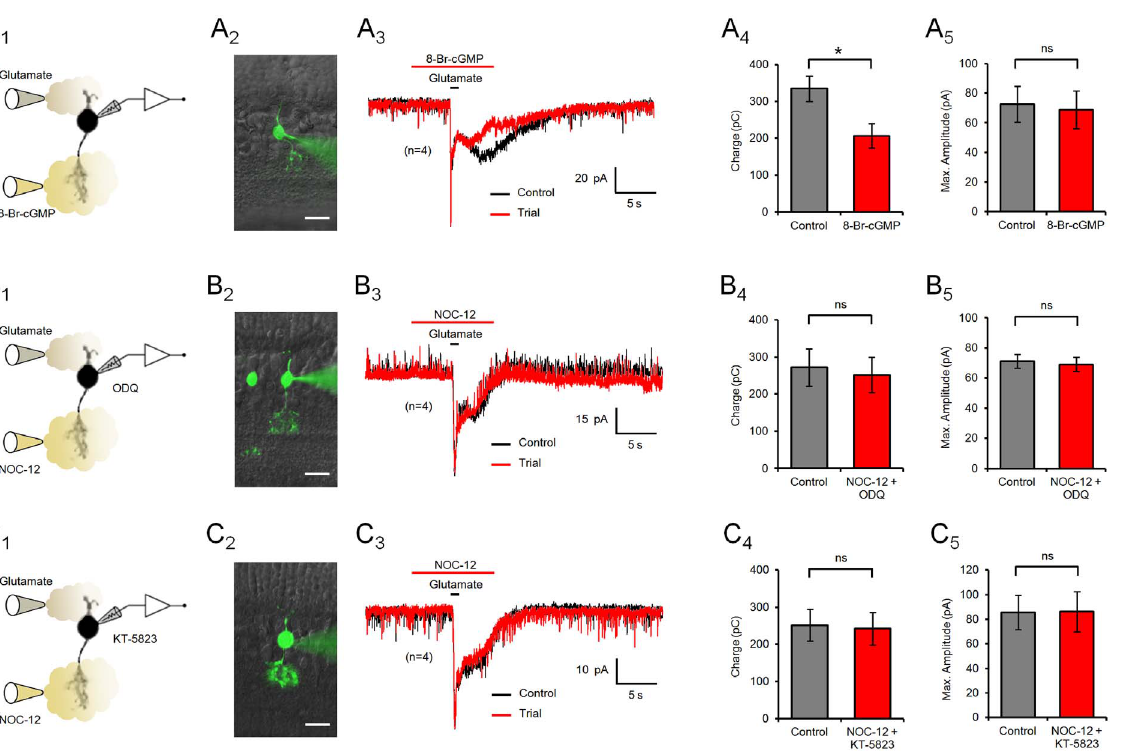
Figure 3. The effect of NO on the slow component of the glutamate response depends on cGMP. (A) Application of the cGMP analog 8-Br-cGMP (1 mM) to the axonal endings of type 4 CBCs (A 1 ) reduced the duration of the slow component of the glutamate response (A 3 ). (A 4 , A 5 ) While the charge transferred during the response was significantly reduced by 8-Br-cGMP, this cGMP analog did not affect the maximum amplitude of the glutamate response. (B) Addition of the sGC inhibitor ODQ (100 m M) to the internal solution of the recording pipette prevented the action of NO on the slow component of the glutamate response in type 4 CBCs (B 3 ). Note the previously recorded ON CBC to the left (B 2 ). (B 4 , B 5 ) Neither the charge transferred during the glutamate response nor the maximum response amplitude were significantly affected by NOC-12 application in presence of ODQ. (C) Similar to ODQ, addition of the PKG inhibitor KT-5823 (1 m M) to the internal solution abolished any effect of NO on the slow component of the glutamate response (C 3 , C 4 ). Note that dialysis of ODQ and KT-5823 had a shortening effect on the slow component of the glutamate response by itself. Image scale bars 5 10 m m; ns 5 not